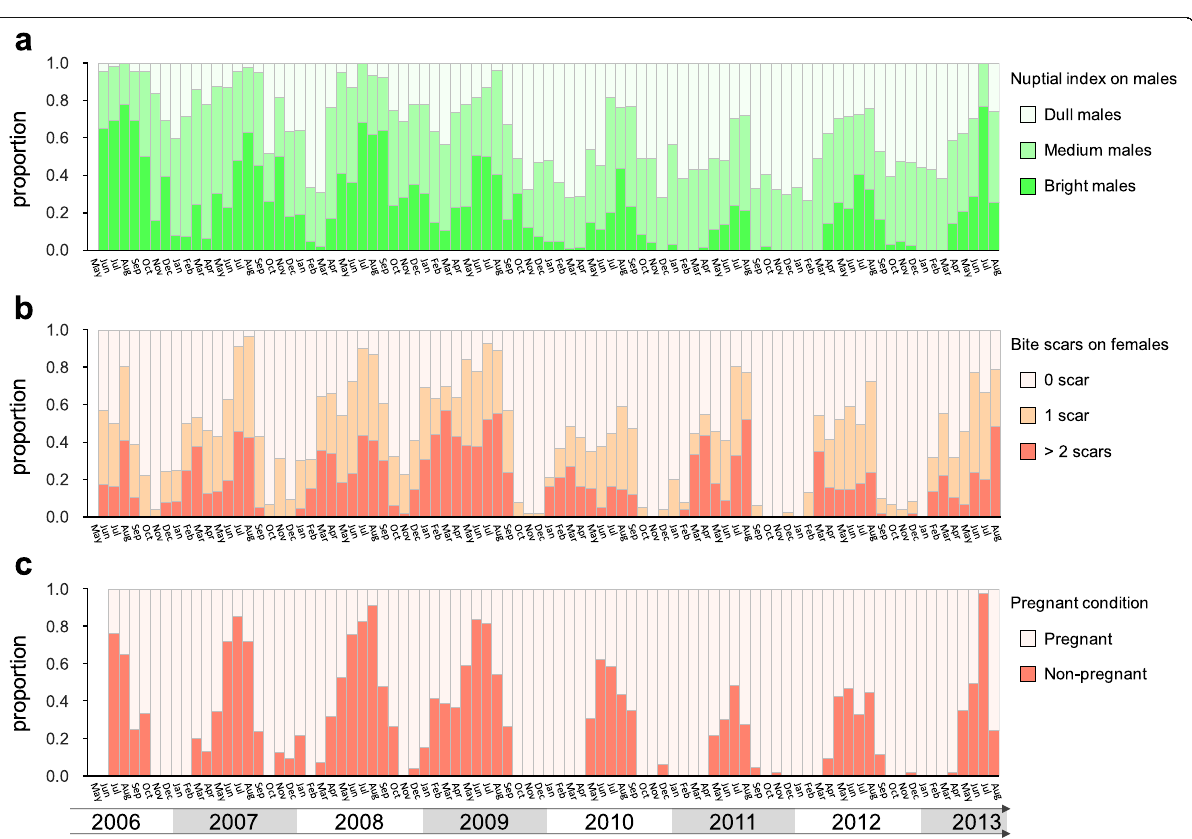
Fig. 2 The annual reproduction cycles of Takydromus viridipunctatus based on the eight-year capture data during 2006 – 2013. The reproduction efforts were represented by three indexes: ( a ) the proportion males with bright, medium, or dull nuptial color, categorized by the coverage of green areas on the lateral sides; ( b ) the proportion of females with different levels of copulation intensity, categorized by the number of bite scars; ( c ) the proportion of pregnant and non-pregnant